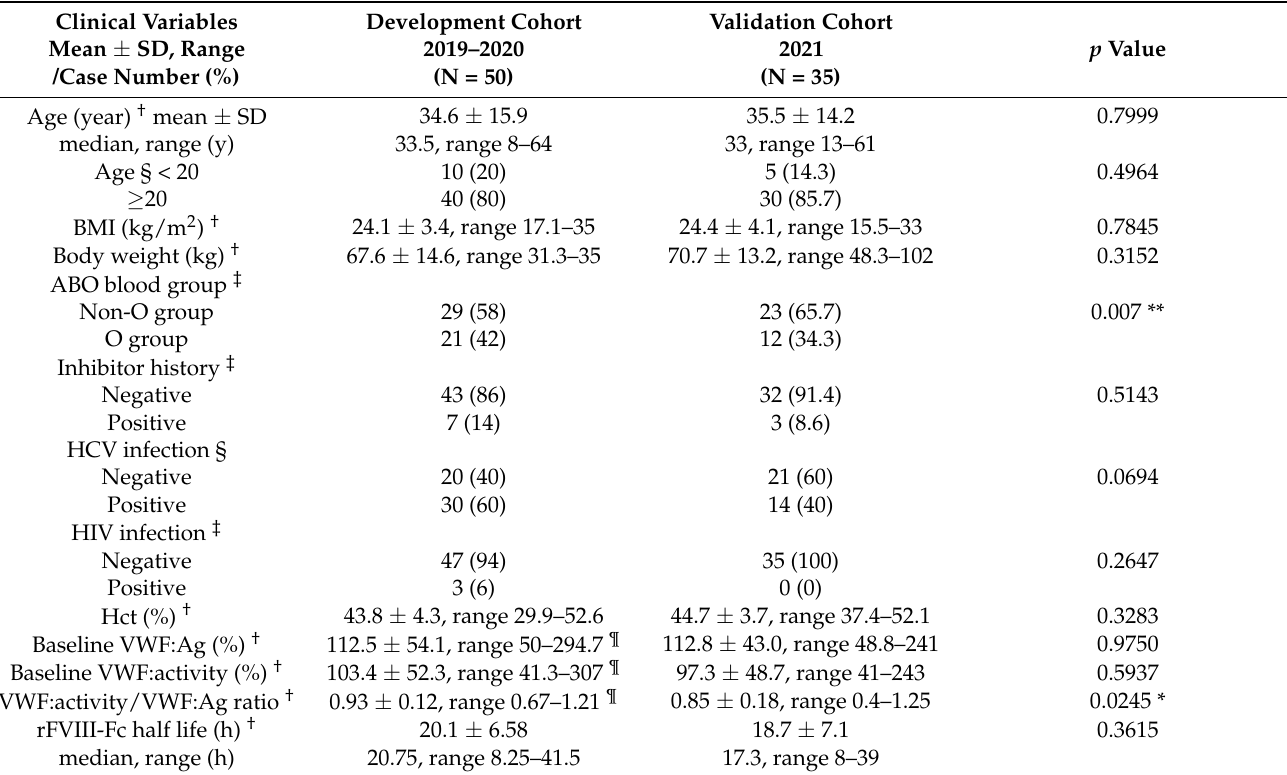
Table 1. Comparison of the clinical features of the development cohort and the validation cohort.